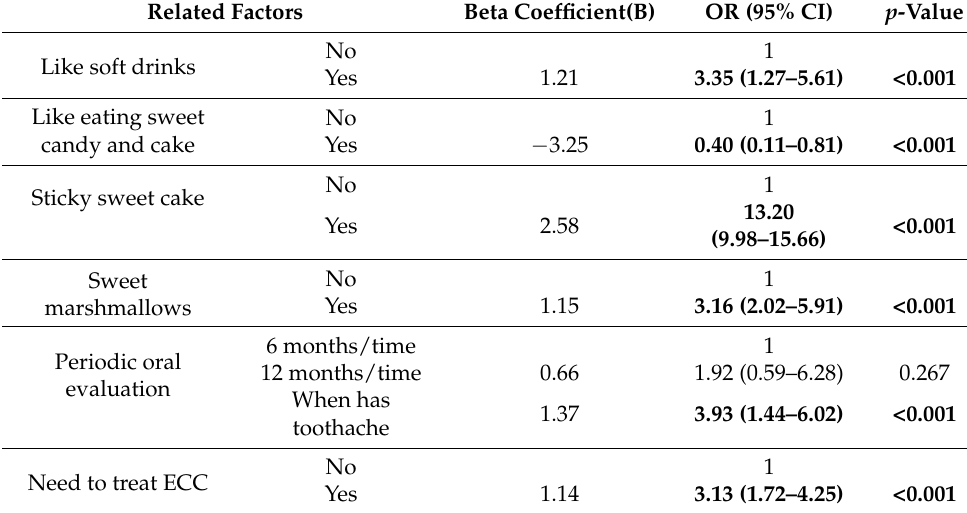
Table 3. Multivariate regression analysis on total study subjects ( n =